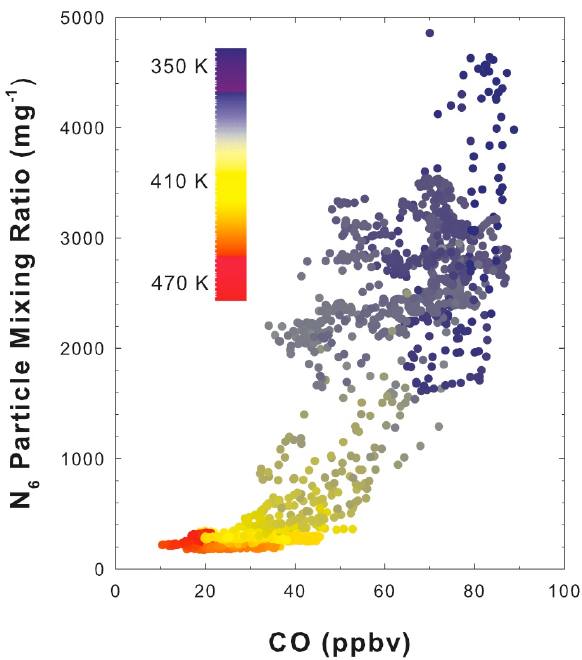
Fig. 11. Scatter plot of CO (ppbv) versus aerosol mass mixing ra- tio (greater than 6nm, less than 1µm) (particles per milligram of air) for local M55 flights over West Africa coloured as a function of potential temperature (K). Aerosol nucleation events have been removed (see text for details).